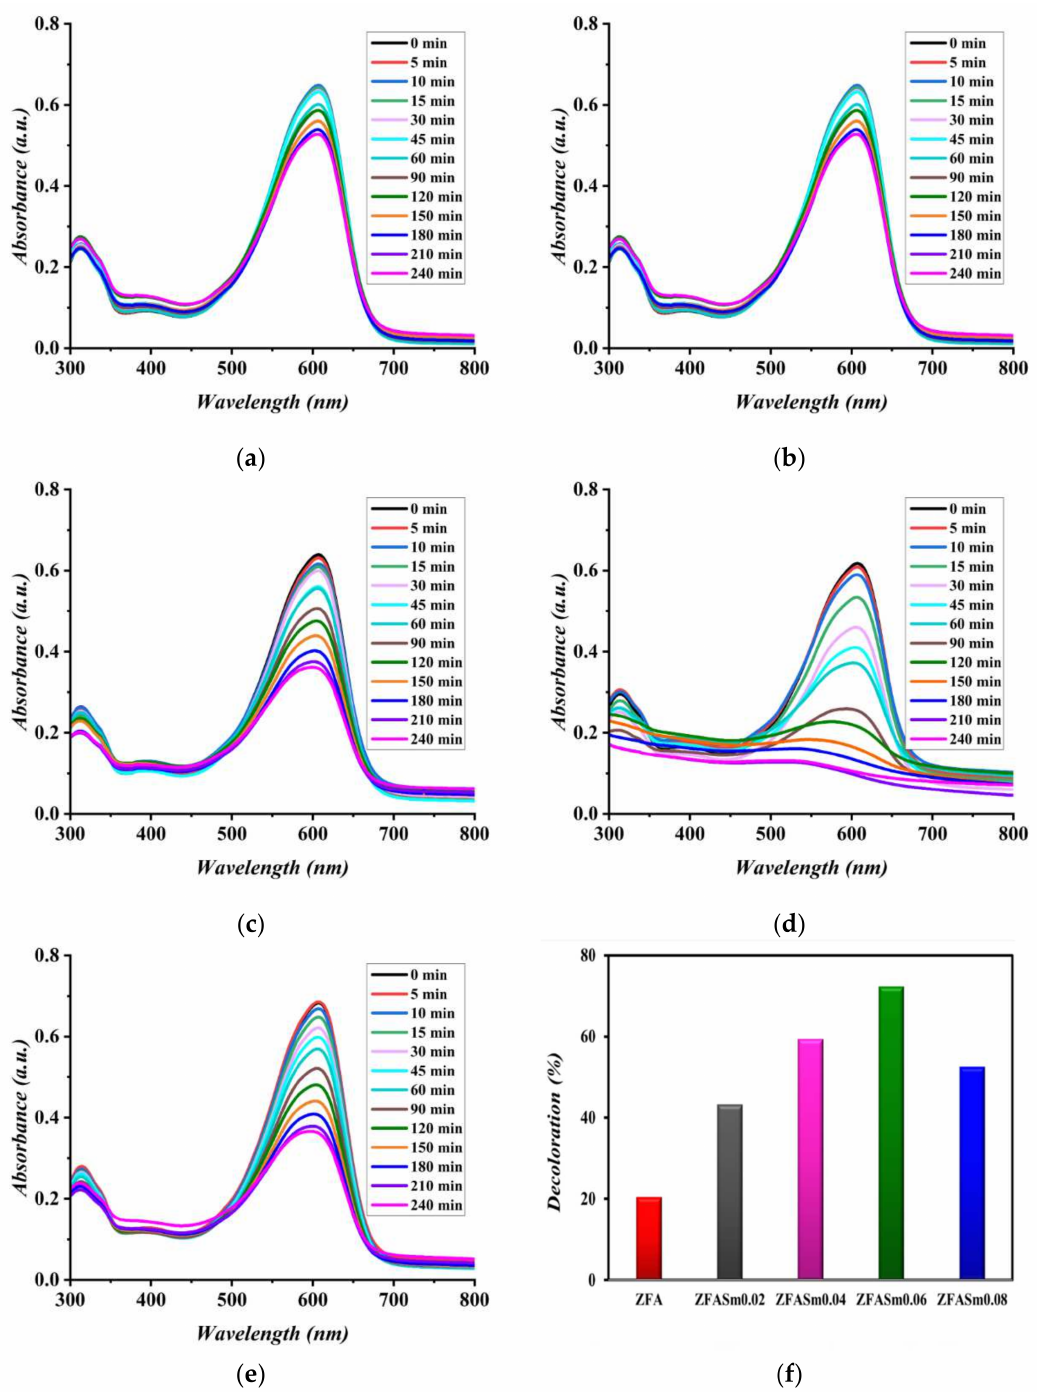
Figure 7. Spectral response of EB during photodegradation in the presence of samples ( a ) ZnAlFeO 4 (ZFA), ( b ) ZnAlFe 0.98 Sm 0.02 O 4 (ZFASm0.02), ( c ) ZnAlFe 0.96 Sm 0.04 O 4 (ZFASm0.04), ( d ) ZnAlFe 0.94 Sm 0.06 O 4 (ZFASm0.06), ( e ) ZnAlFe 0.92 Sm 0.08 O 4 (ZFASm0.08), and ( f ) colour-removal efficiency after 1 h of pho- tocatalytic reaction, in the presence of ZnAlFe 1 − x Sm x O 4 (x = 0, 0.02, 0.04, 0.06, 0.08)